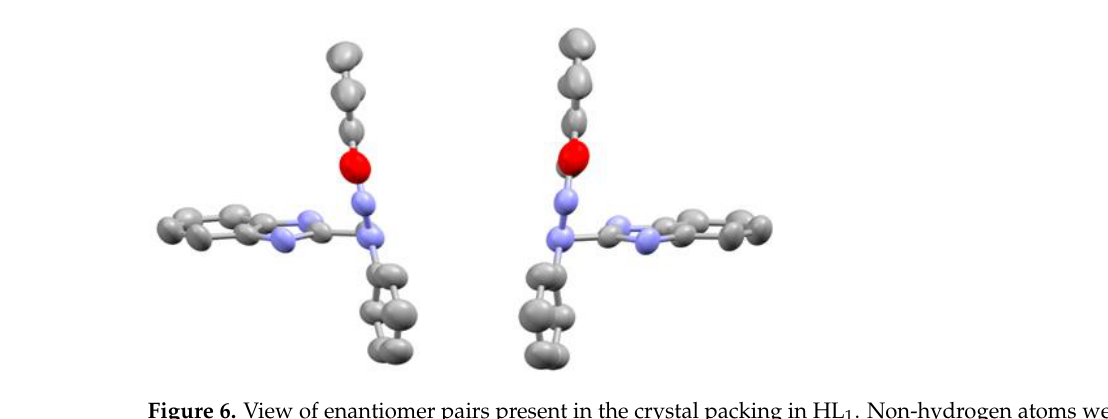
Figure 6. View of enantiomer pairs present in the crystal packing in HL 1 . Non-hydrogen atoms were drawn using 50% probability ellipsoids. Hydrogen atoms were omitted for simplicity. The drawings were made with the mercury 3.8 program.